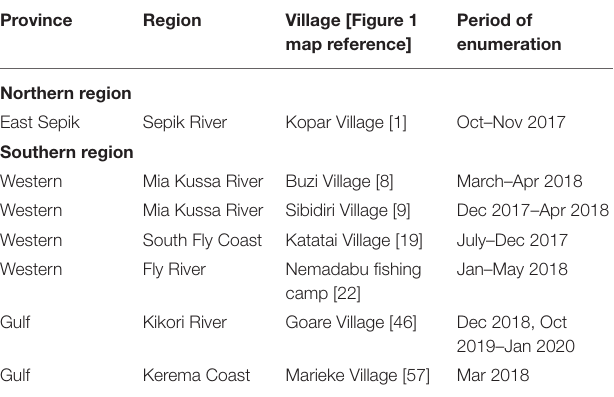
TABLE 2 | Location of enumerators and the time period when they collected data on elasmobranch landings. Province